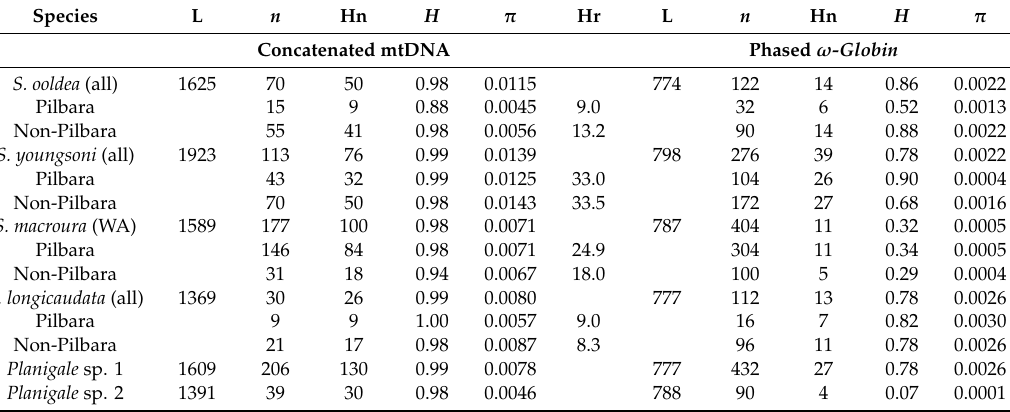
Table 2. Molecular diversity indices for the concatenated mtDNA ( CR + cytb ), and the phased nuclear ( ω -globin ) gene alignments of the six species in this study. Indices are also calculated for species within and outside of the Pilbara where appropriate. Number of samples ( n ), sequence length in base pairs excluding alignment gaps (L), number of haplotypes or alleles (Hn), haplotype diversity ( H ), nucleotide diversity ( π ), haplotypic richness under rarefaction (Hr). Species L n Hn